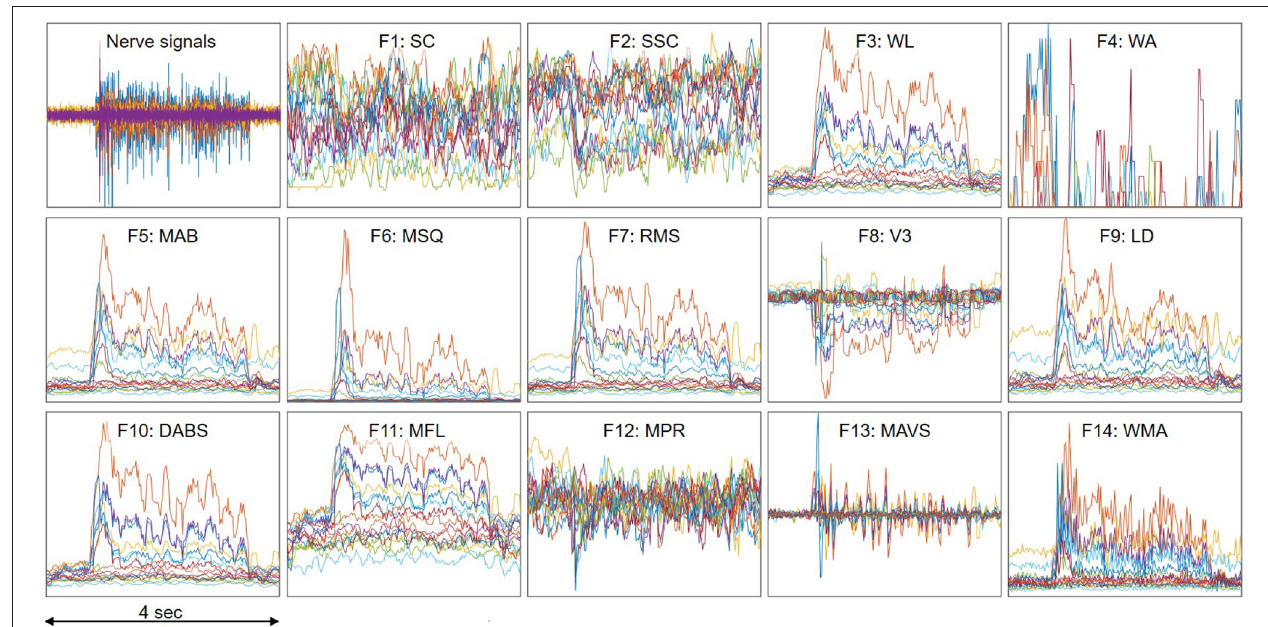
FIGURE 4 | An example of feature data in one trial which shows clear correlation with the finger’s movement. A trial includes the finger’s movement from resting to fully flexing and back to resting. Each color represents one of the 16 recording channels. The amplitude of each feature is normalized by a fixed value.